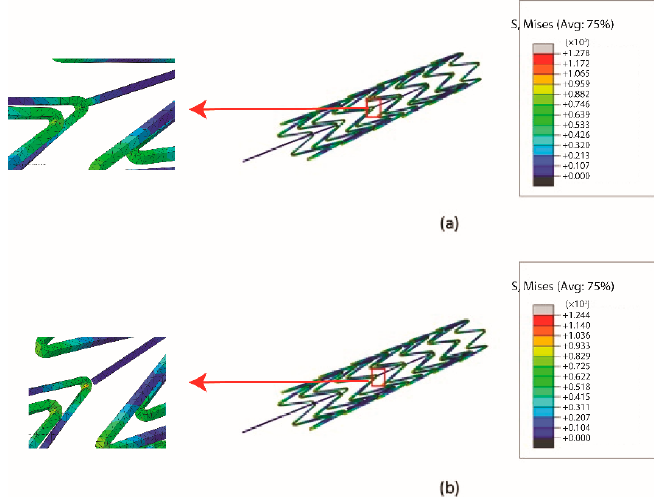
Figure 8. The simulated Von-Mises stress distributions of the ( a ) multi-connector, and ( b ) single- connector stent antennas via mechanical FEM simulations.